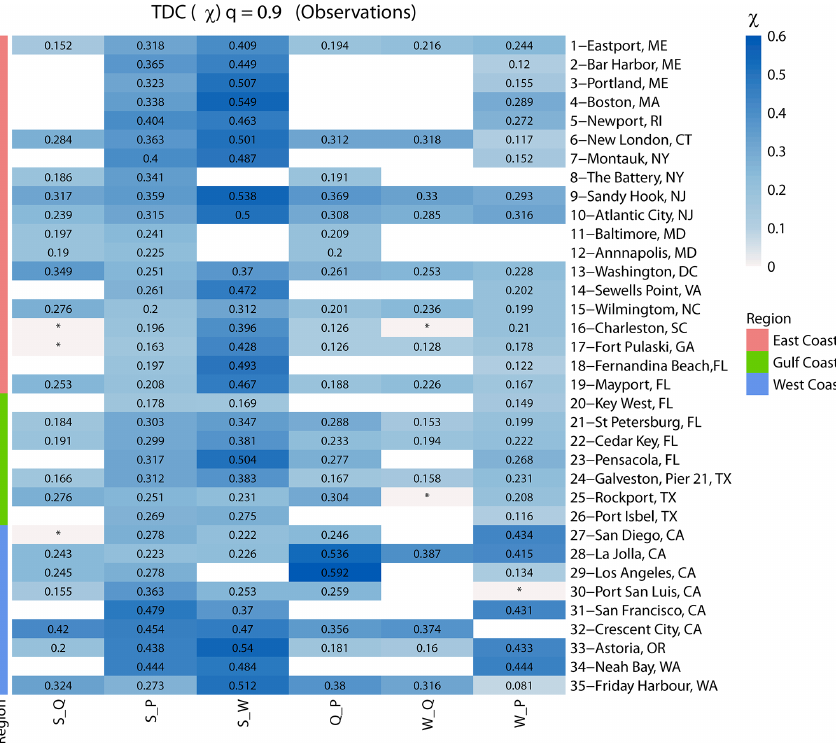
Figure 4. Tail dependence χ between different pairs of flooding drivers for a threshold of q = 0 . 9. Sites are grouped into locations on the East, Gulf, and West coasts (see colours on the left and in the legend). The blue colour bar denotes tail dependence strength, blank squares indicate that data for the particular pair did not exist, or that the number of overlapping years was less than 20, and squares with an asterisk ( ∗ ) indicate that dependence is not significant.